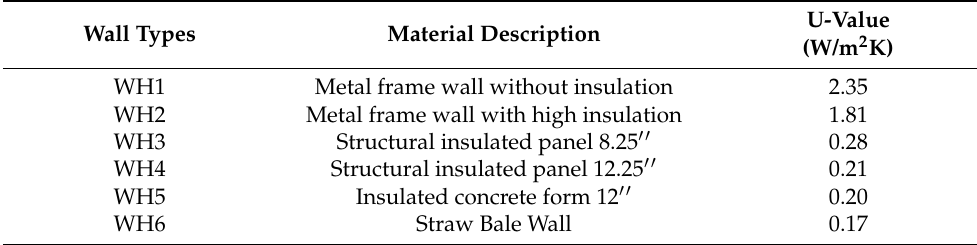
Table 5. Different types of wall materials for warehouse